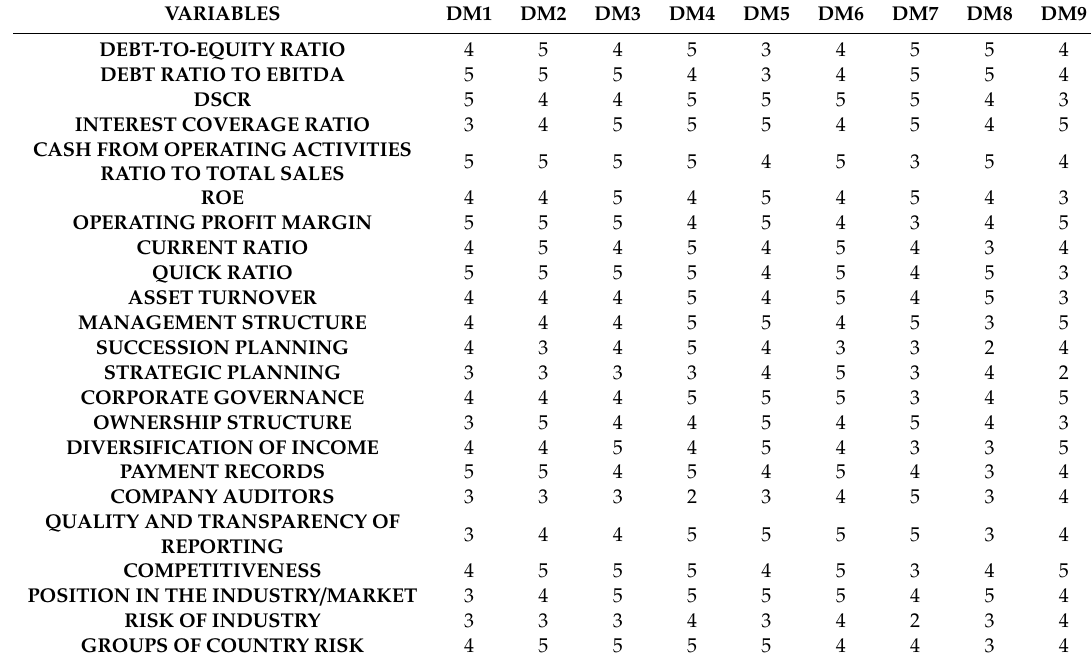
Table 1. Preferences of experts (decision makers (DM)) regarding input variables. DEBT-TO-EQUITY RATIO (Earnings Before Interest, Taxes, Depreciation and Amortization(EBITDA)), Debt-Service Coverage Ratio (DSCR), Return On Equity (ROE), Definitions of these input variables are provided in Table 3.